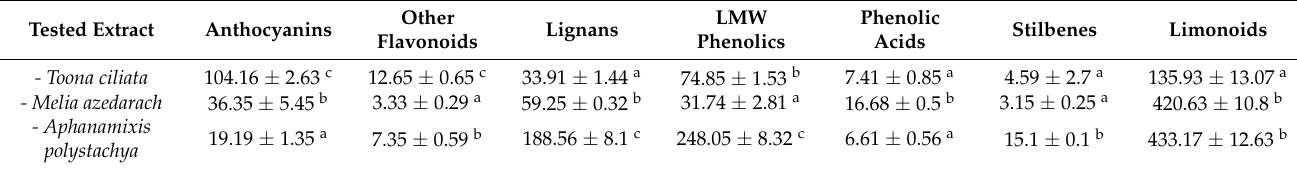
Table 1. Phytochemical composition of the different extracts of Meliaceae species. The results are expressed as mean value ( n = 3; mg/g dry matter) ± standard deviation. Superscript letters within each column indicate significant differences, as resulted by one-way ANOVA and Duncan’s post hoc test ( p <